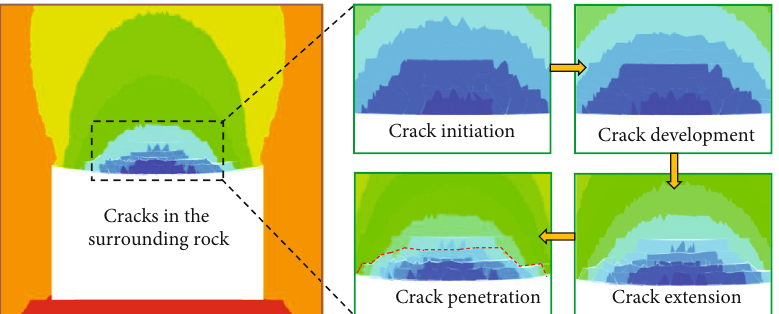
Figure 9: Crack evolution process in the roof.